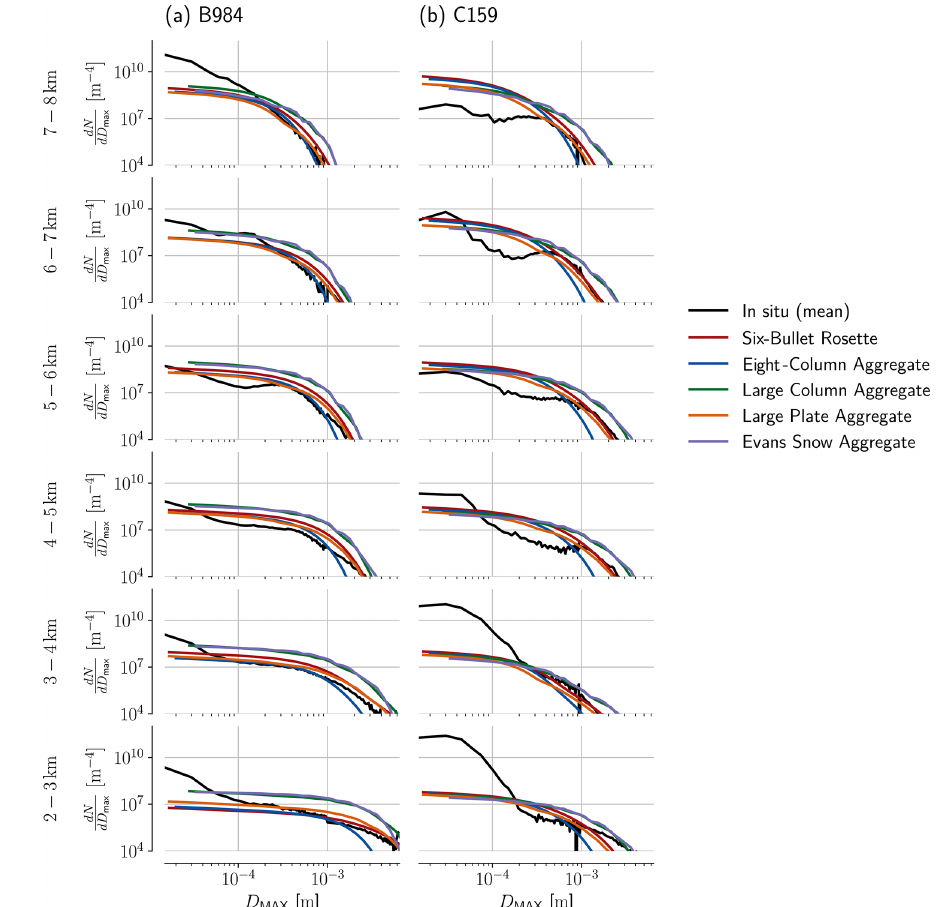
Figure 17. In situ-measured and retrieved PSDs for flight B984 retrieved using the combined (a) and the radar-only retrieval (b) . Each row of panels shows the mean of the in situ-measured PSDs (black) together with randomly drawn samples of measured PSDs (light grey) for a given altitude bin of a height of 1km. Colored lines on top show the corresponding mean retrieved PSD for different assumed particle